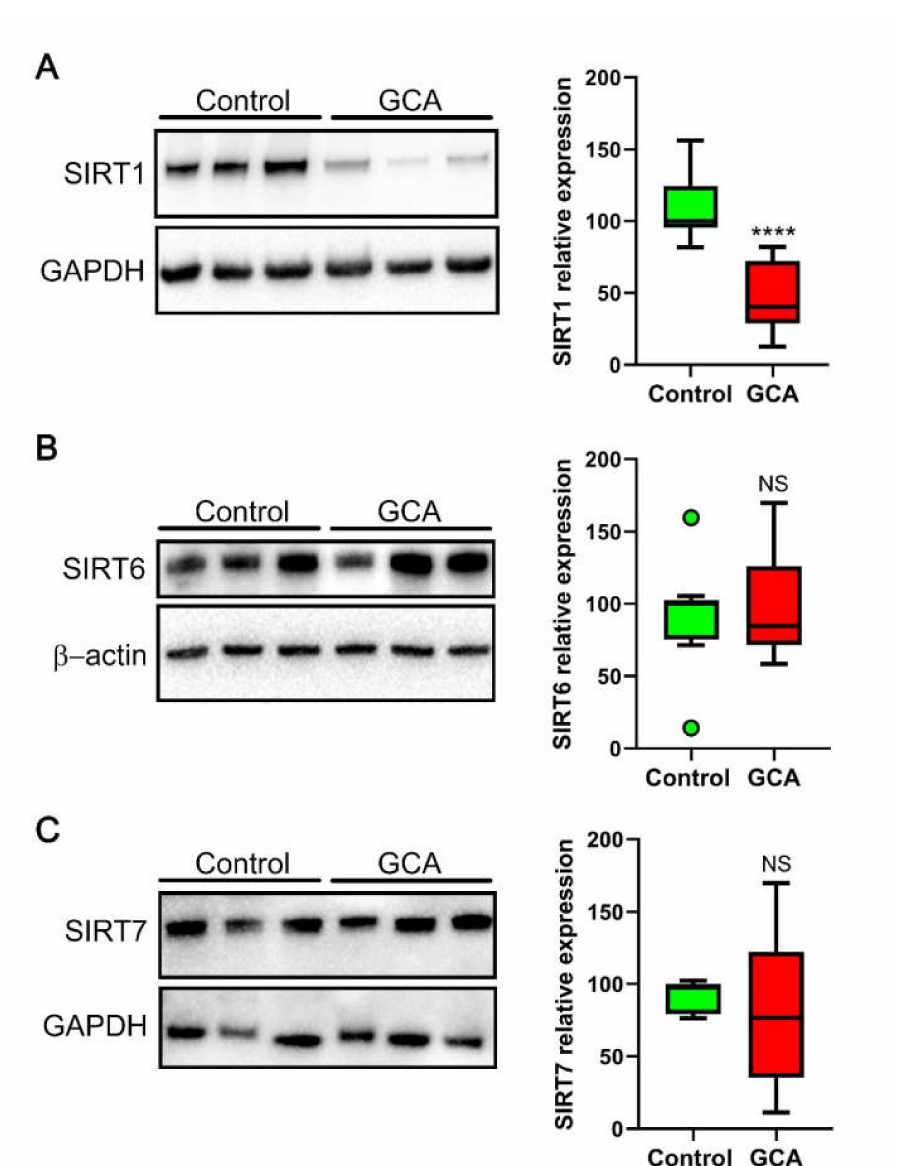
Figure 3. Western blot analysis of SIRT1 ( A ), SIRT6 ( B ) and SIRT7 ( C ) expression in PBMCs derived from the GCA patients and healthy controls. Quantification of sirtuins expression normalized to the relative loading control (GAPDH or Actin) ± SD is shown in the right histograms ( n = 9; **** p < 0.0001; NS: not